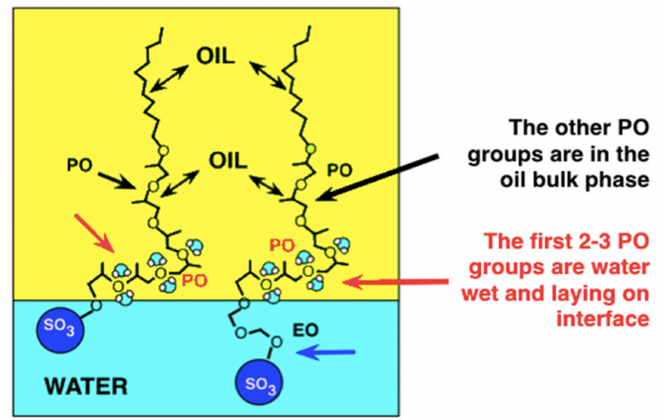
Figure 17. Typical extended surfactant molecules containing a polypropylene oxide (PO) intermediate (with a sulfate head on the left and a di-ethoxy-sulfate on the right). Adapted from [85].